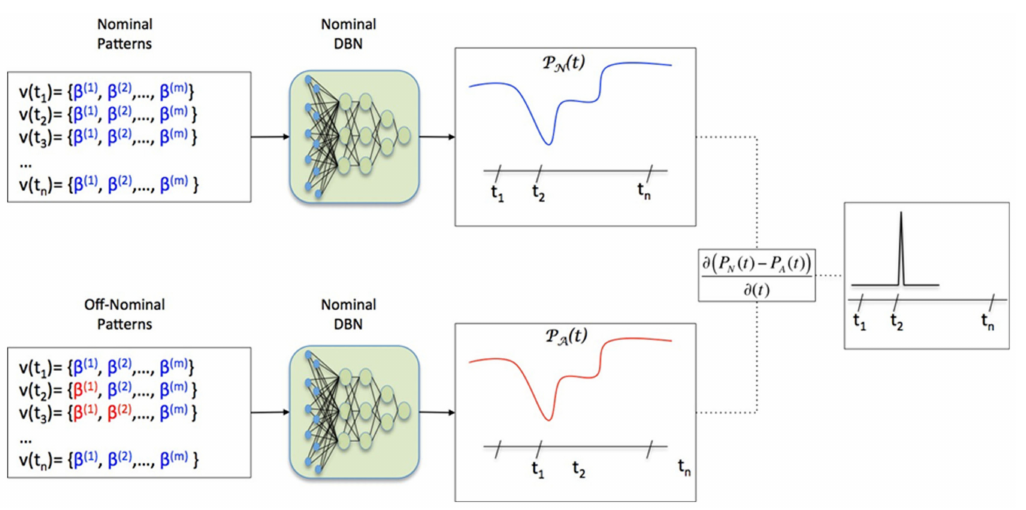
Figure 6. Detection by comparison of signals using nominal patterns as the basis to contrast with o ff -nominal patterns.